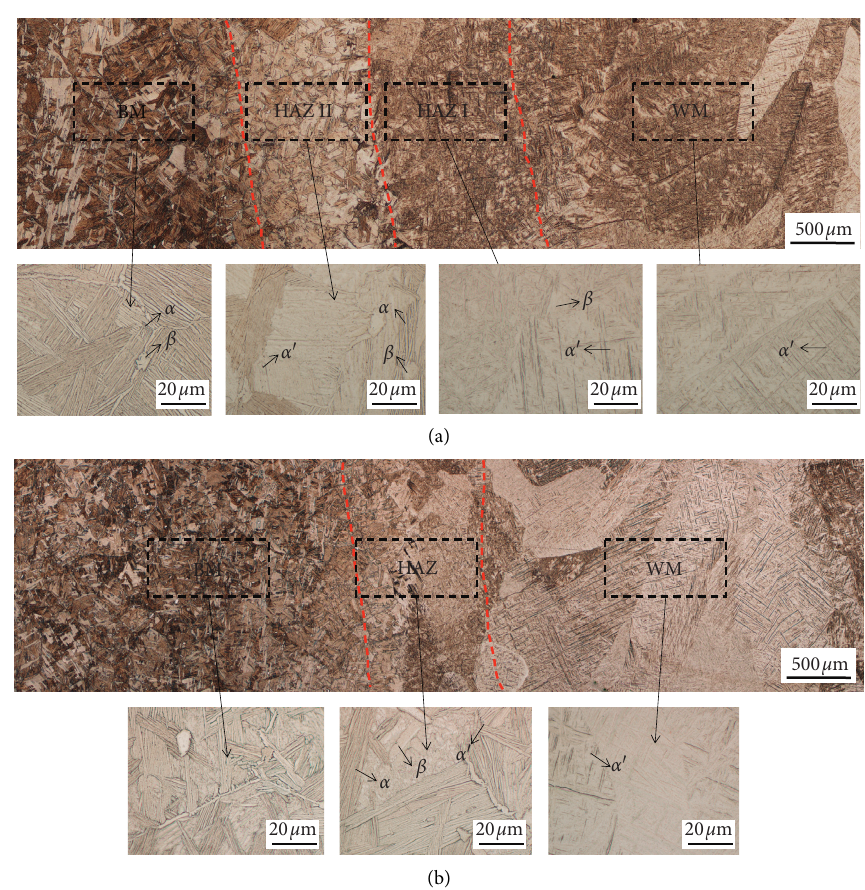
Figure 6: Microstructures of weld metals jointed with different shielding gases: (a) Ar; (b)